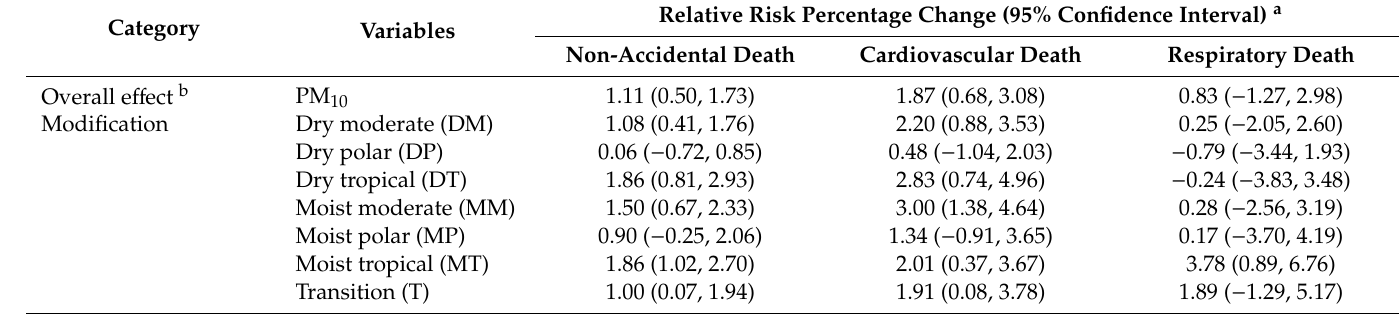
Table 2. Relative risk percentage change between daily mortality and PM 10 concentration and the modification with synoptic weather type in Seoul, South